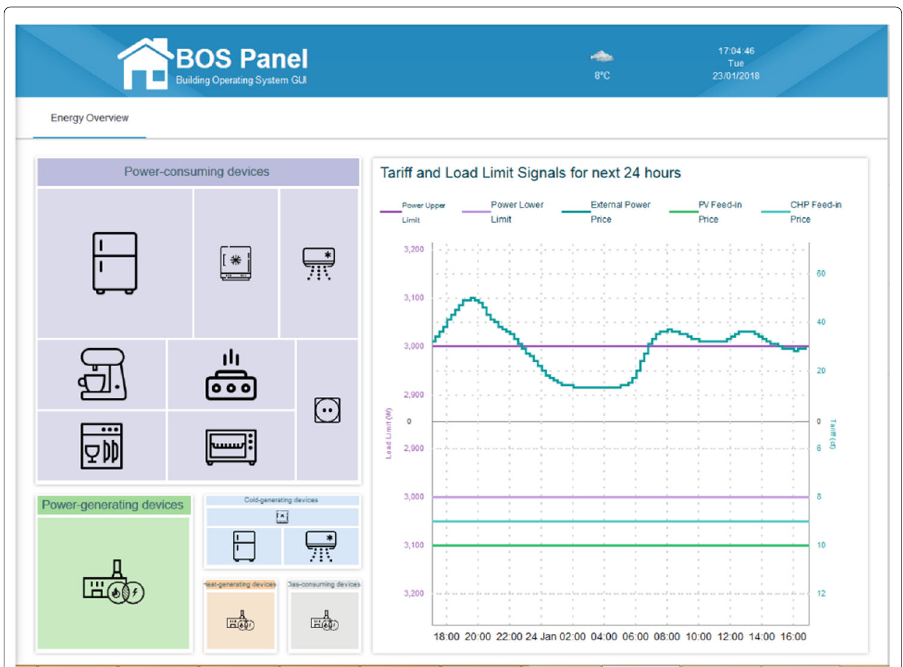
Fig. 15 BOS UI: resized and rearranged widgets for the energy overview